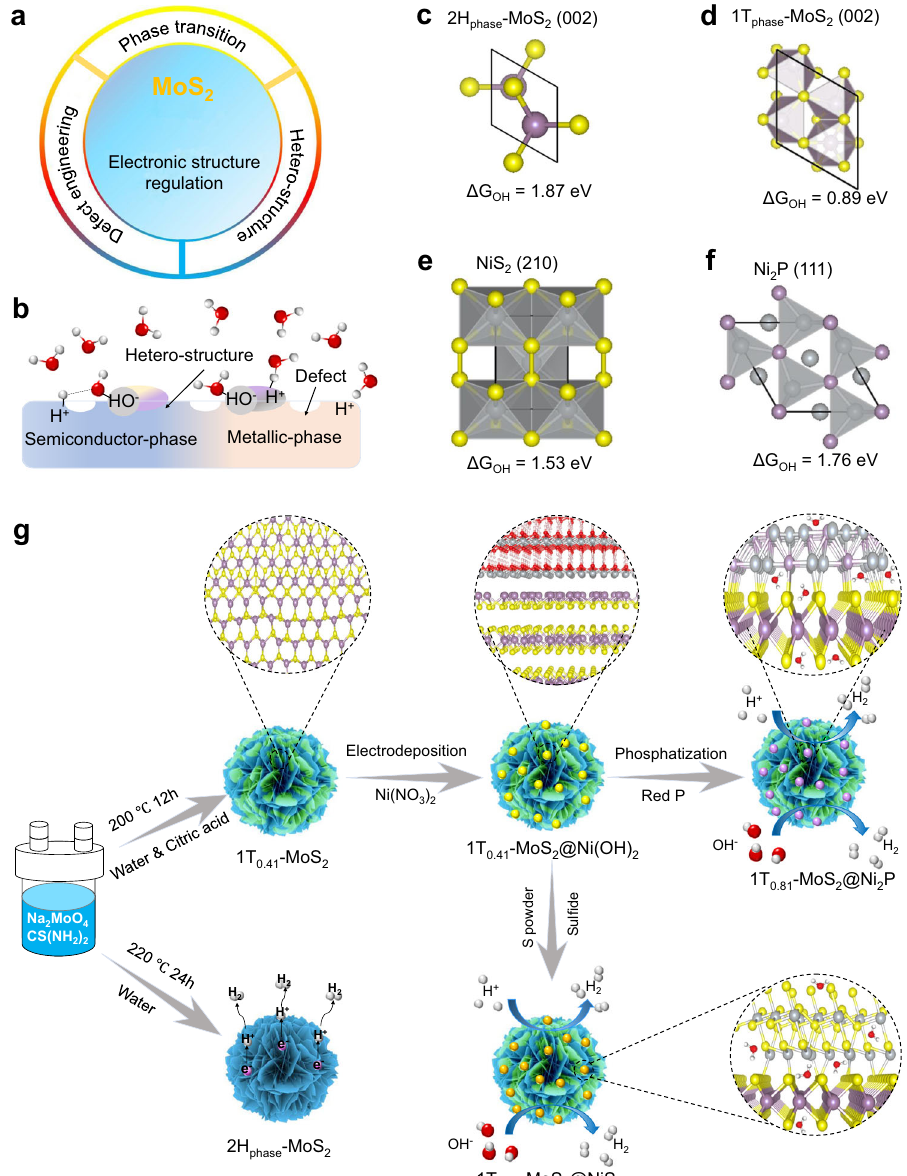
Fig. 1 Motivation and design of electrocatalyst. a Tuning strategy of the electronic structure of the MoS 2 surface. b Design ideas of hydrogen evolution catalyst. c – f the energetics of hydroxyl species on 2H phase -MoS 2 (002), 1T phase -MoS 2 (002), NiS 2 (210), and Ni 2 P (111) HER electrocatalyst surfaces. g Schematics of the 1T 0.72 -MoS 2 @NiS 2 and 1T 0.81 -MoS 2 @Ni 2 P synthesis